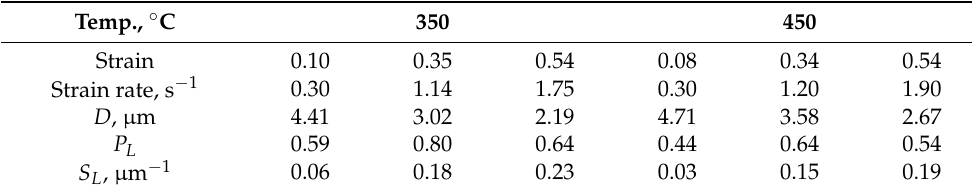
Table 4. Microstructure parameters of the AlMg6/10 % SiC MMC at temperatures of 350 and 450 °C.